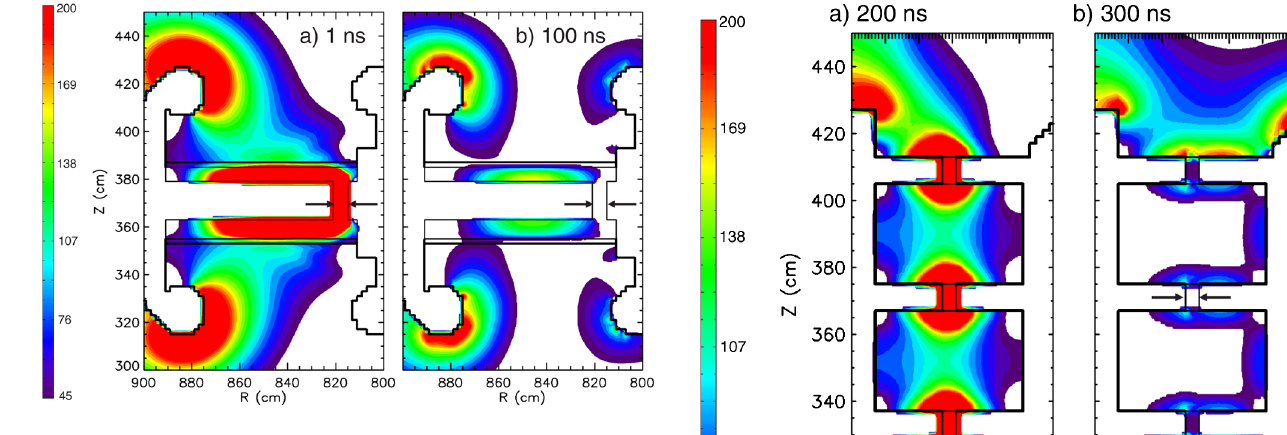
FIG. 8. (Color) Electric-field magnitude in the upper module laser-triggered gas switch in the (cid:2) ¼ 0 plane at 1 and 100 ns. The arrows indicate the location of the conductivity channel in the switch.